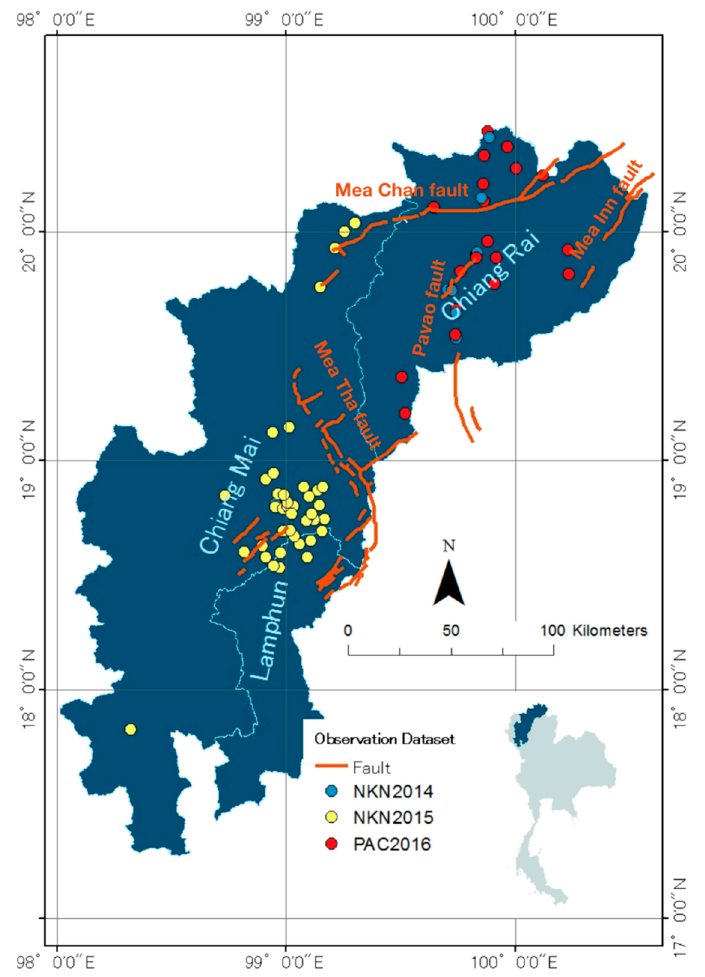
Figure 1. Study area: the districts of Chiang Mai, Chiang Rai, and Lamphun with the V S30 observation stations.